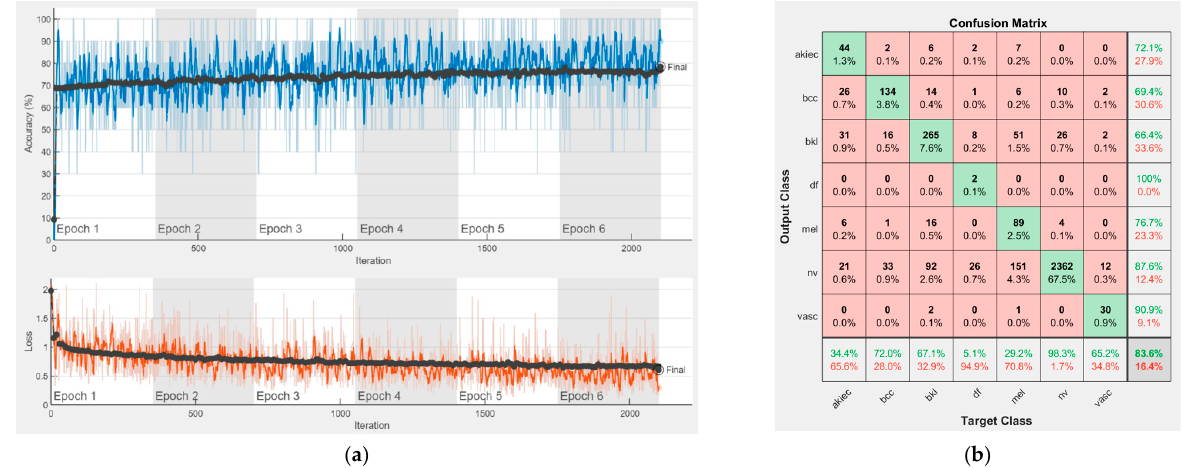
Figure 13. Results using Xception, ( a ) Accuracy and loss, ( b ) Confusion matrix.